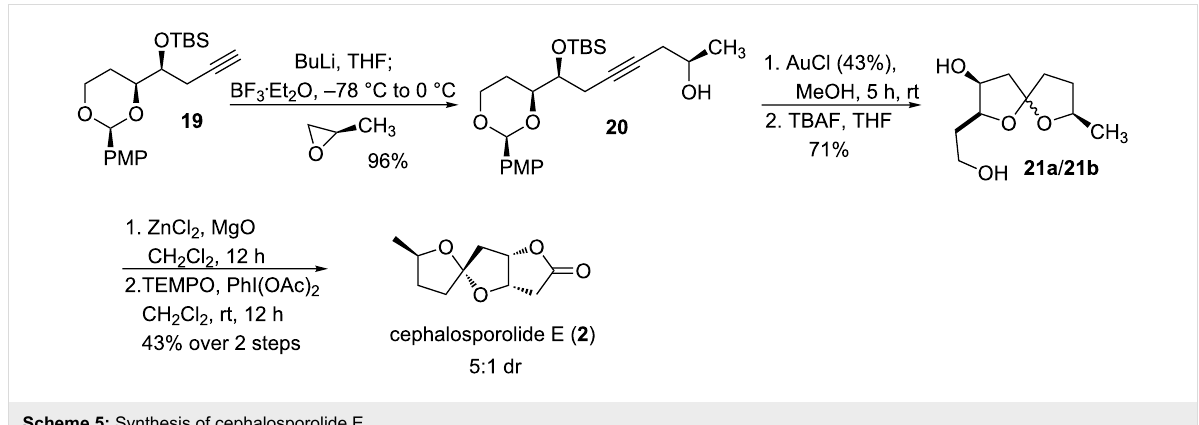
Scheme 5: Synthesis of cephalosporolide